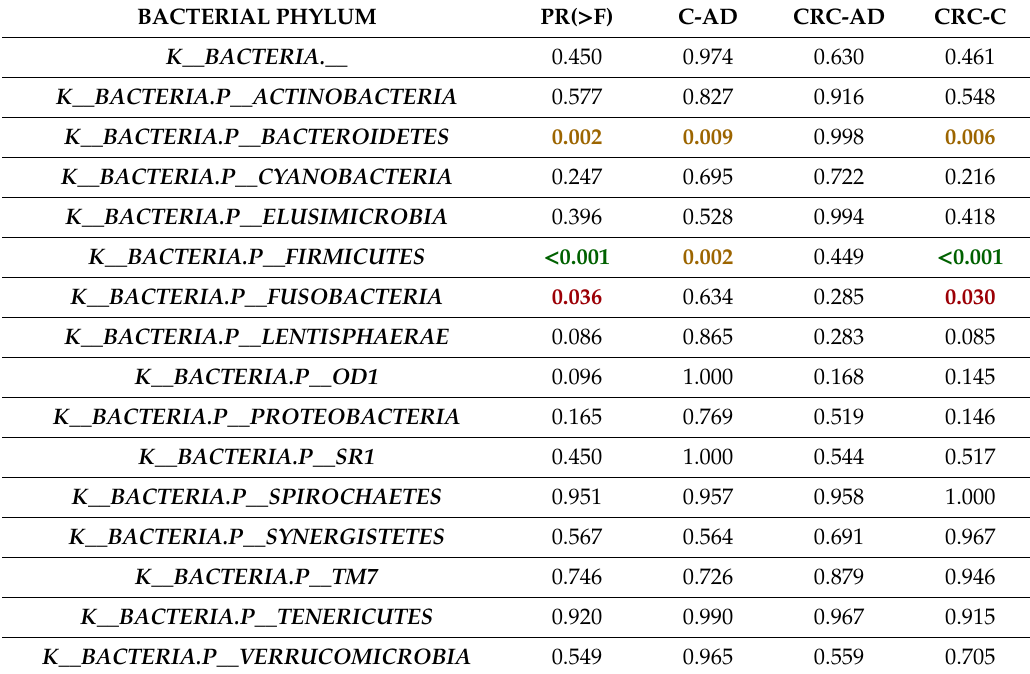
Table 1. Di ff erences between the identified phyla mean relative abundances per sample group comparison. ANOVA values are indicated in the first column, while Tukey’s HSD test p -values are indicated per each pairwise comparison in the other columns. In black, non-significant di ff erences, in red are indicated the p -values between 0.05 and 0.01, in yellow the p -values between 0.01 and 0.001 and in green the p -values <